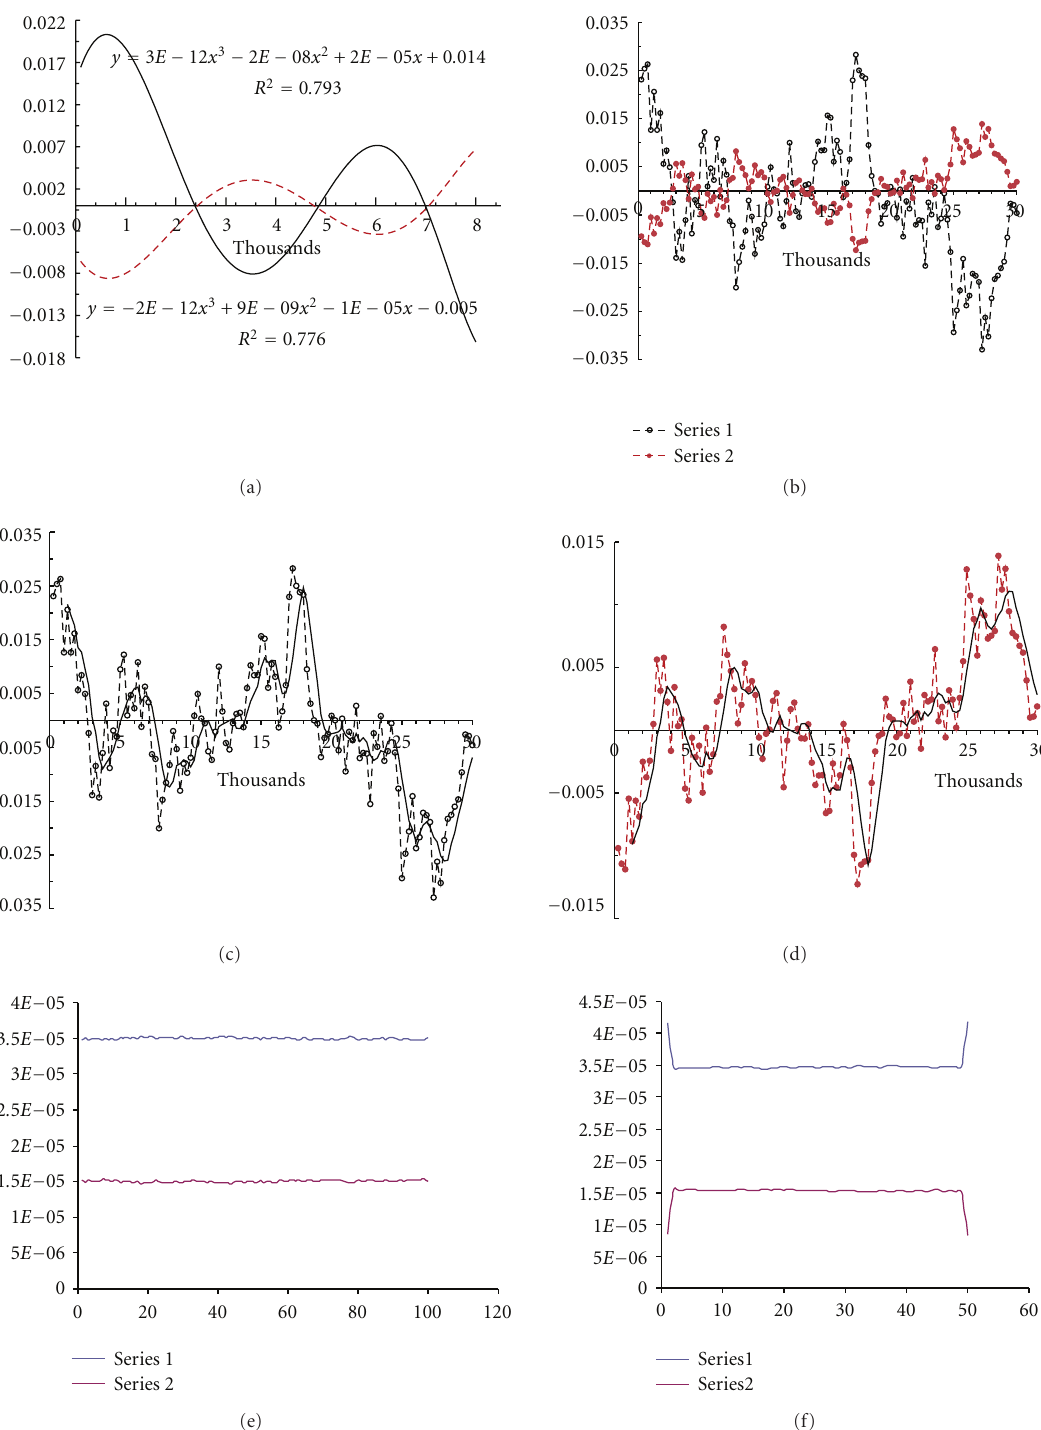
Figure 9: It shows (a) spatial correlation fits well to higher order polynomial specially in early phases of evolution; spatial correlation versus MC cycles (b) spatial correlation versus MC cycles, the open dots represent the preferred component B (i.e., majority component) and solid ones the other one (i.e., minority component-A) (c) spatial correlation of B (average fitting) versus MC cycles (d) spatial correlation of A (average fitting) versus MC cycles (e) average number density of A and B—profile parallel to the substrates and (f) average number density of A and B—profile perpendicular to the substrates. All averages are done after every 250 cycles (except (a) after 100 MC